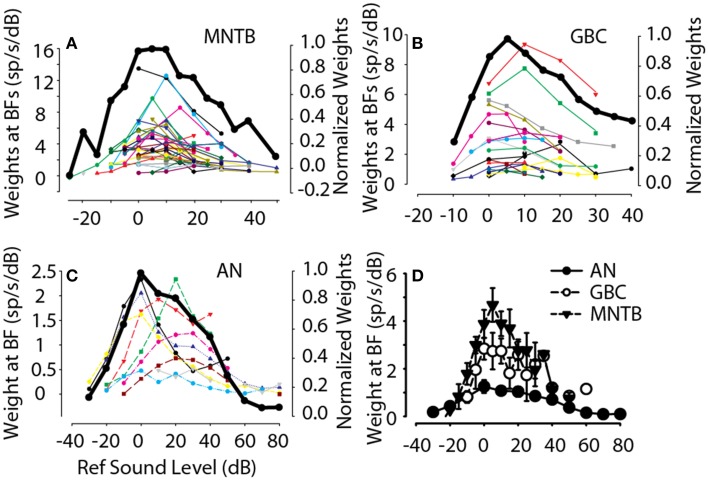
Dependence of first-order weights at BF on overall sound level. For all MNTB (A), GBC (B), and ANF (C) neurons studied (individual lines and symbols), the first-order weight at BF (left-hand ordinate) is plotted as a function of sound level (re: threshold for flat-spectrum stimulus, Figure 1A). In general, for each neuron the first-order weights were small for low and high sound levels and peaked for moderate sound levels. To summarize this trend, the solid black line shows the across-neuron mean first-order weight as a function of sound level; data for individual neurons was first normalized by the maximum weight before averaging across neurons. (D) Summarizes the across-neuron first-order weights at BF in AN, GBC, and MNTB neurons.